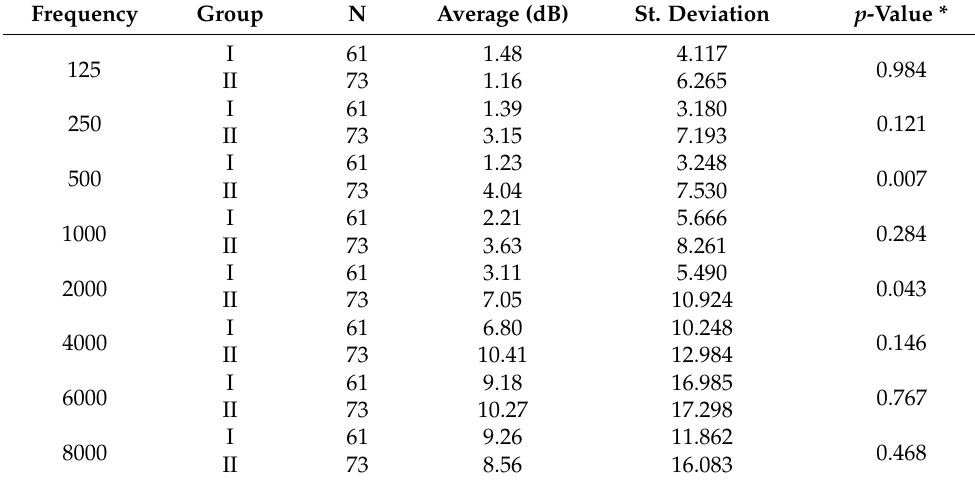
Table 3. Success of particular medical protocols—Group I (corticosteroids therapy without HBO2), Group II (corticosteroids therapy with HBO2) and Singled out group (p. o. vasodilatants). Group I n = 61 ears (corticosteroids without HBO2) Improved 50–82% Improved to normacusis (threshold of losses above 20 dB) 39–64% Group II n = 73 ears (corticosteroids with HBO2) Improved 56–77% Improved to normacusis (threshold of losses above 20 dB) 27–37% Singled out group p. o. vasodilatants n = 7 ears Improved 6–86% Improved to standard (threshold of losses above 20 dB) 2–29% Table 4. Group I (corticosteroids therapy without HBO2) and Group II (corticosteroids therapy with HBO2) changes of threshold of hearing before and after the